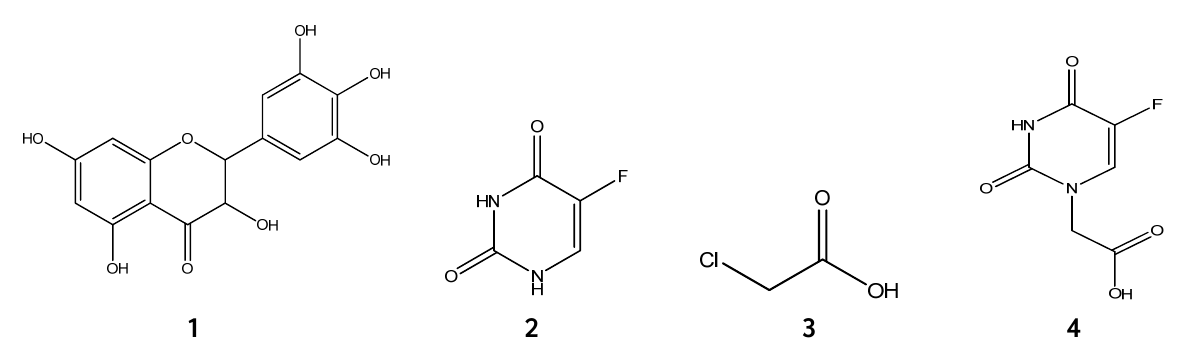
Figure 1. Structures of the